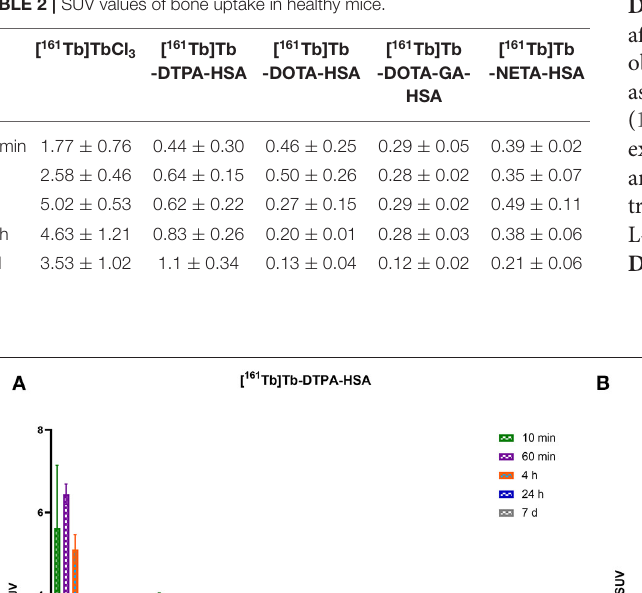
Frontiers in Medicine |